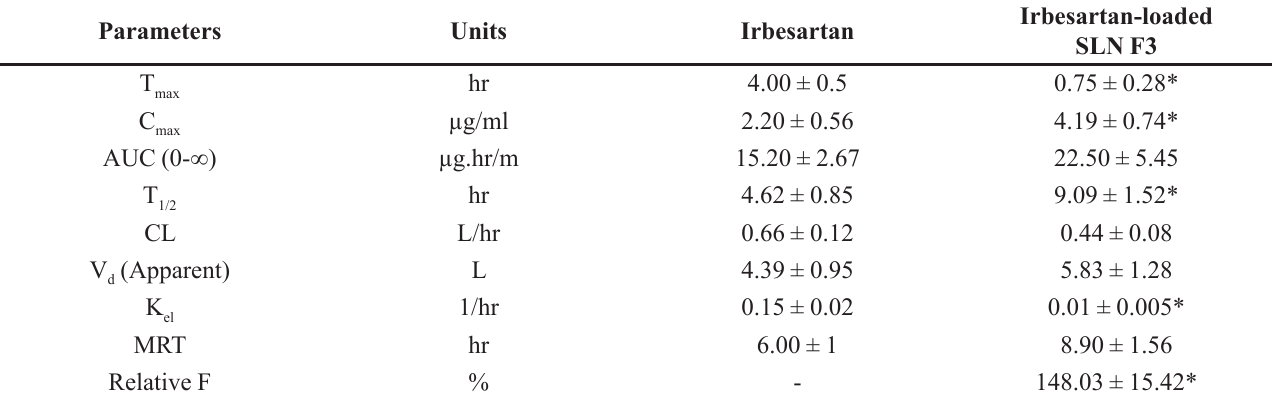
TABLE V - Pharmacokinetic parameters of irbesartan and irbesartan-loaded SLN F3 Parameters